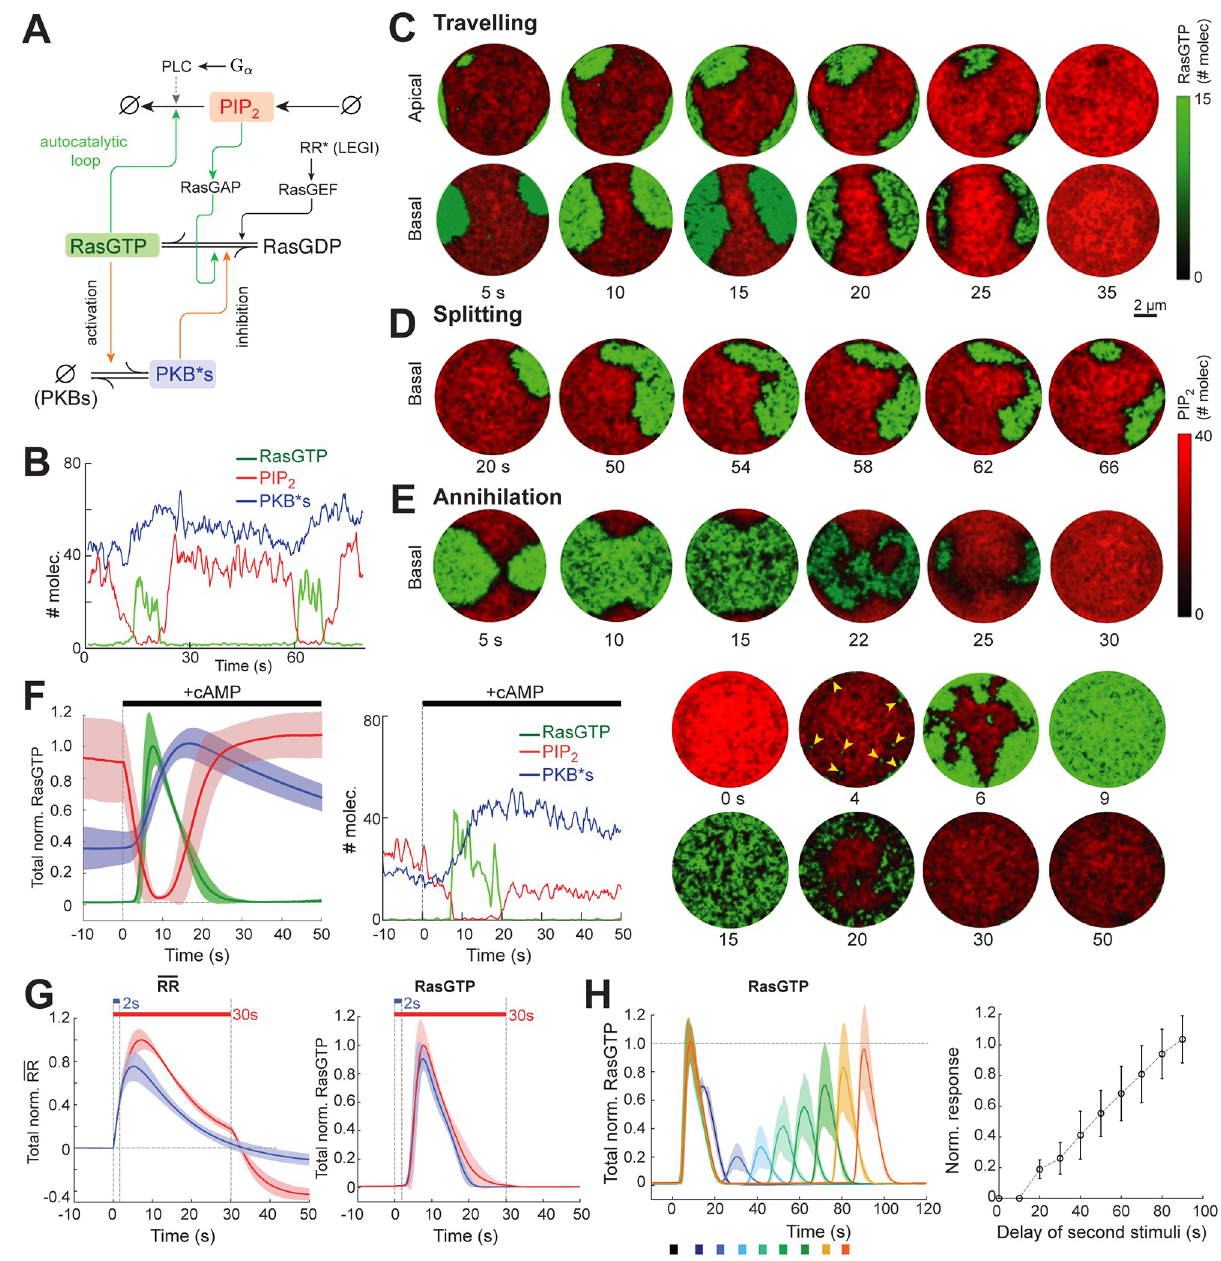
Fig 5. Response of STEN to global stimulus. (A) Schematic of STEN showing the entities: RasGTP, RasGDP, PIP 2 PKBs, PKB � s and their interactions. Green arrows denote positive feedback whereas, orange arrows complete the negative feedback on RasGTP. (B) Temporal profiles of RasGTP (green), PIP 2 (red) and PKB � s (blue) at a random node that has fired spontaneously. (C–E) Spatiotemporal profiles of RasGTP (green) and PIP 2 (red) of the membrane showing wave-traveling (C), splitting (D) and annihilation (E). (F) Response to a spatially uniform dose of cAMP. Shown are the global RasGTP, PKB � s and PIP 2 responses (left), and same at a single random node (center) and the spatiotemporal profile (RasGTP, PIP 2 ) at the basal surface of the cell (right). The yellow arrowheads denote wave initiation sites. Colors are as in panels B–E. The shaded region in the left panel is the standard deviation as in Fig 4D ( n = 10). The peaks of the RasGTP and PKB � s profiles correspond to approximately 165,000 and 275,000 molecules. PIP 2 peaks at approximately 1,000 molecules/ μ m 2 similar to that reported in [58]. (G) Basal subtracted normalized RR ( RR , left) and RasGTP (right) responses to short (2 s, blue) and long (30 s, red) stimuli. The solid lines and the shaded regions are as in panel F ( n = 10). (H) RasGTP response to the two short pulses (2 s) of spatially uniform stimuli with variable delays. Left: temporal mean nodal profile of RasGTP ( n = 10). Right: plot of normalized peak of the second response to the first versus the delay between the stimuli.